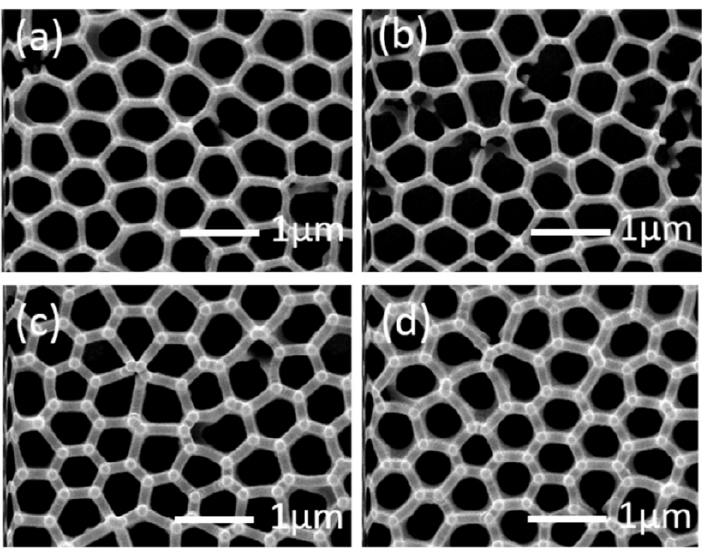
Figure 18. SEM images of ( a ) an anodized alumina oxide (AAO) layer; ( b ) an AAO + 10 nm Al 2 O 3 ; ( c ) an AAO + 20 nm Al 2 O 3 ; and ( d ) an AAO + 20 nm TiO 2